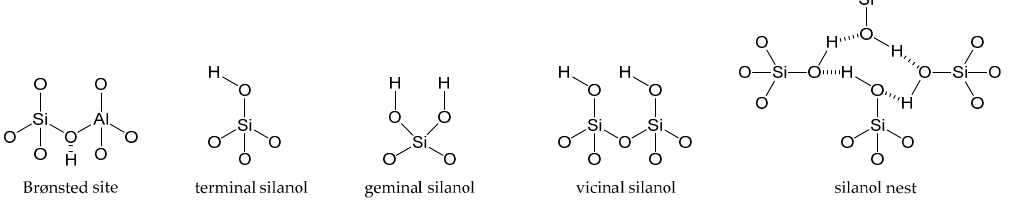
Figure 2. A depiction of the different types of acid site in zeotype materials (modified from reference [42]).